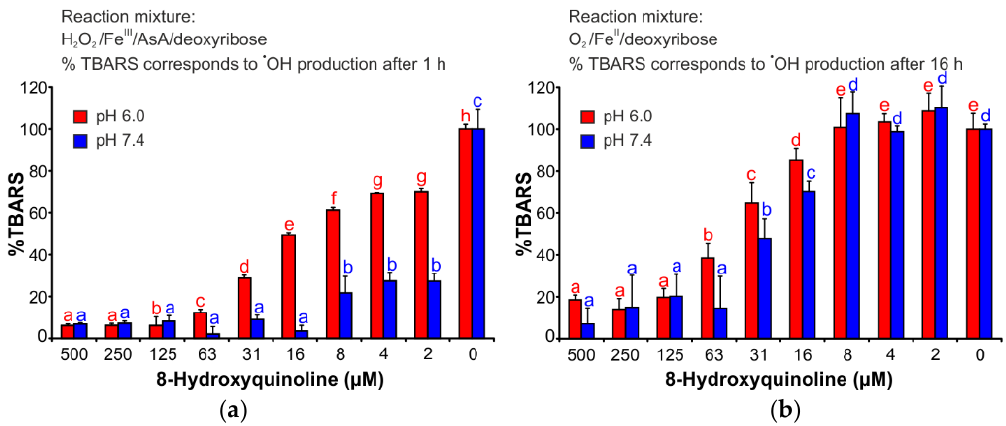
Figure 3. Antioxidant effects of 8HQ in ( a ) deoxyribose degradation assay and ( b ) iron (II) autoxidation assay. The bars are the means of three replications ( ± S.D.). Letters a–h in subfigure ( a ) and a–e in subfigure ( b ) indicate significance levels (95% Duncan’s post hoc test). AsA: ascorbic acid; TBARS: thiobarbituric acid reactive species; S.D.: standard deviation.